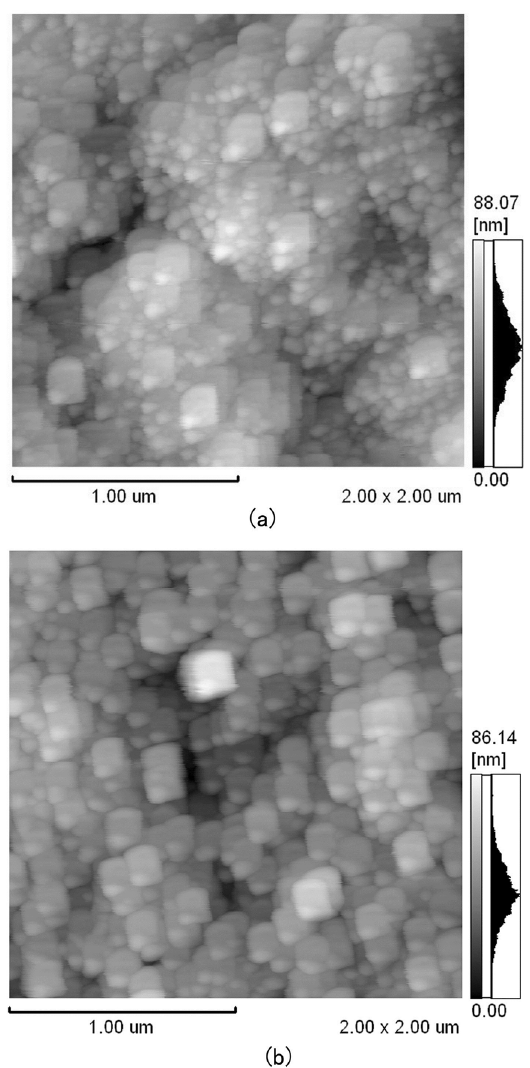
Figure 2. The surface morphology images of as-deposited films observed by AFM (a: Al film. b: TiO